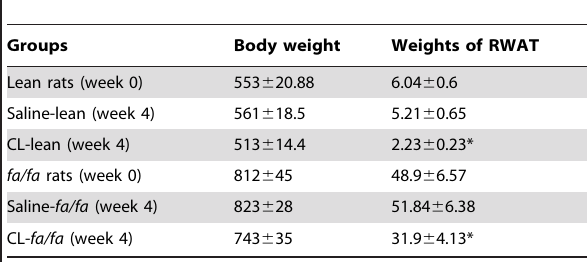
*Signifcant effect of CL compared with saline-treated rats of the genotype.